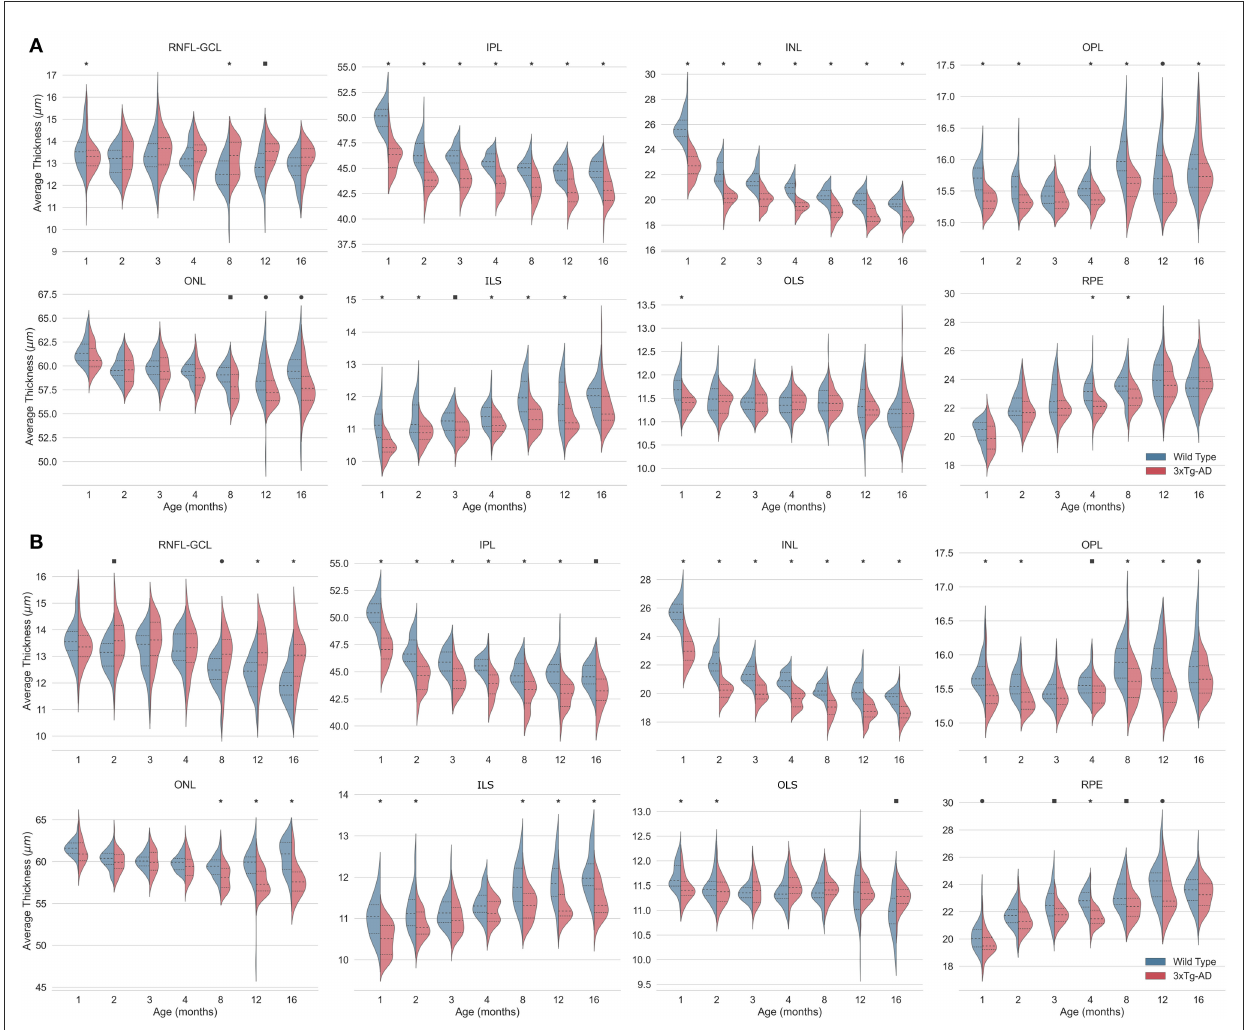
FIGURE4 Kernel density estimates of retinal thickness per layer for the left (A) and right (B) eyes of wild-type (blue) and the triple transgenic Alzheimer’s disease (3xTg-AD) mice (red). Median (dashed) and first and third quartiles (dotted) are shown. Bonferroni correction was applied per time point to correct for multiple comparisons. p -values < 0.05 ( • ), < 0.01 ( (cid:4) ), and < 0.001 (*). RNFL-GCL, retinal nerve fiber layer and ganglion cell layer complex; IPL, inner plexiform layer; INL, inner nuclear layer; OPL, outer plexiform layer; ONL, outer nuclear layer; ILS, photoreceptor inner segments; OLS, photoreceptor outer segments; RPE, retinal pigment